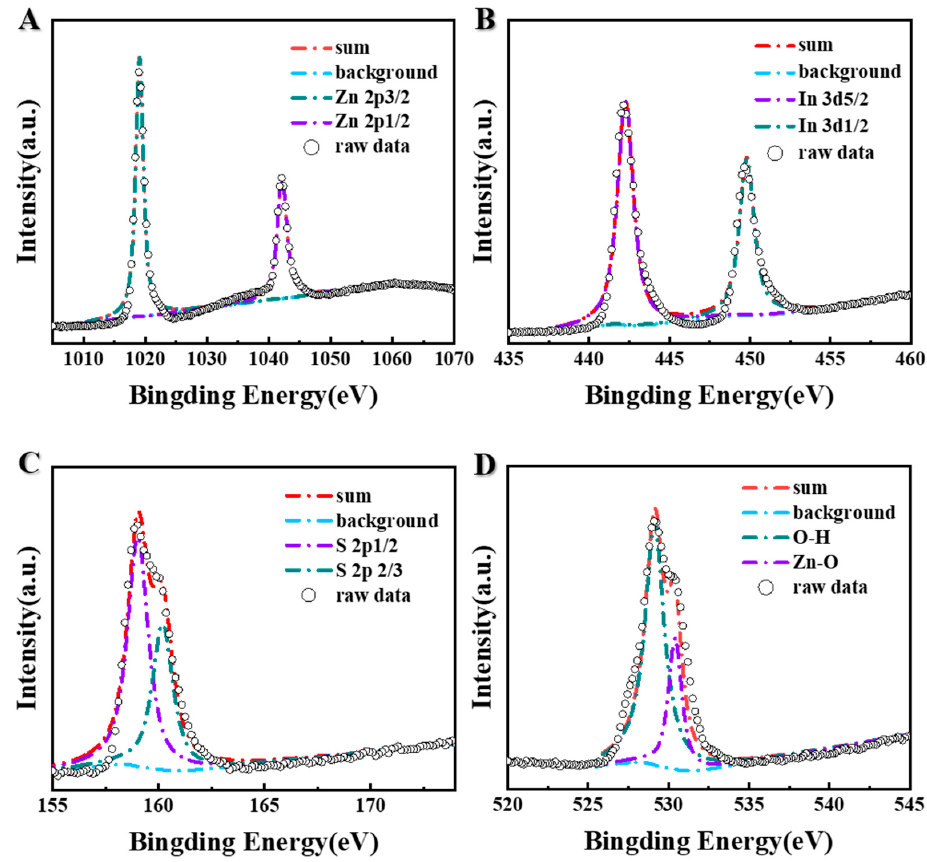
Figure 3. XPS spectrum of the ZnO/ZnIn 2 S 4 heterojunctions: Zn 2p ( A ), In 3d ( B ), S 2p ( C ), and O 1s ( D ).